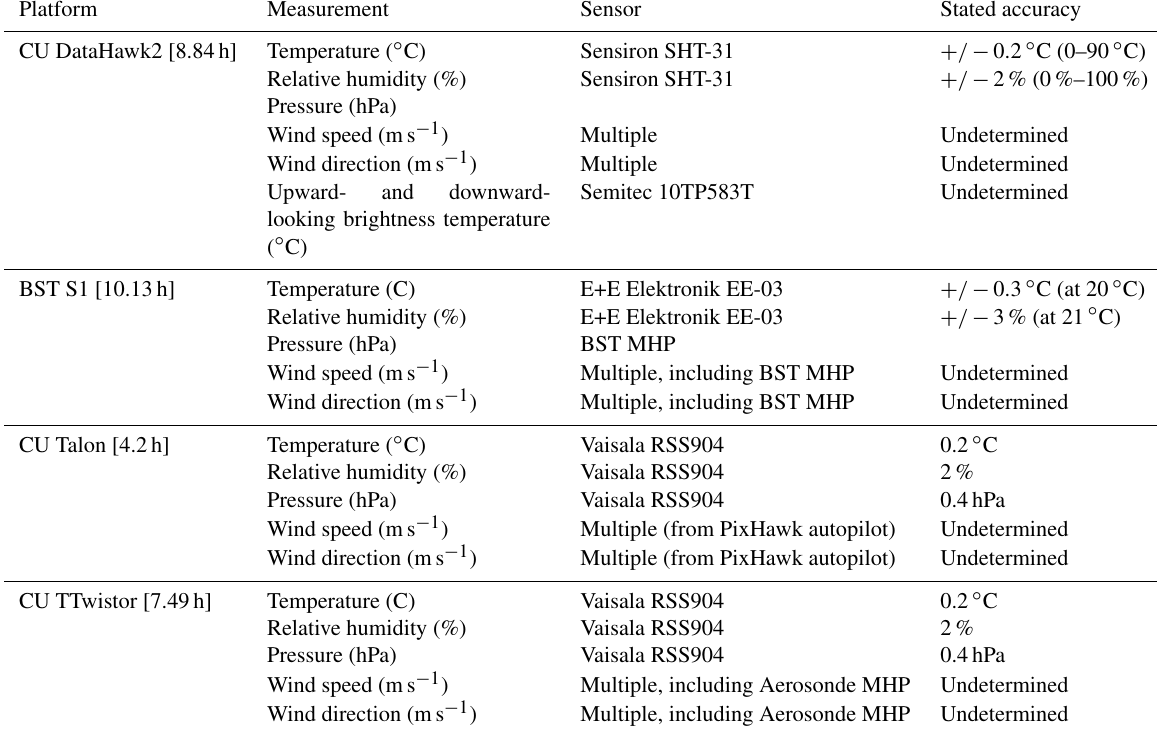
Table 1. An overview of the platforms and meteorologically relevant measurements from each. The total number of campaign flight hours covered by each platform are included in brackets in the first (leftmost)